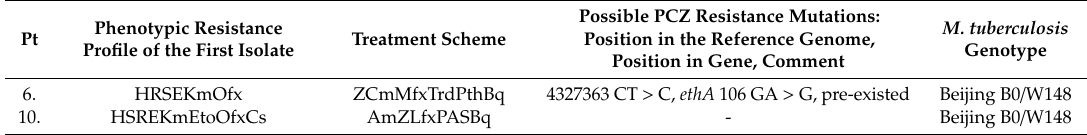
Table 2. Summary of enrolled tuberculosis patients and infecting M. tuberculosis isolates for patients not treated with perchlozone.